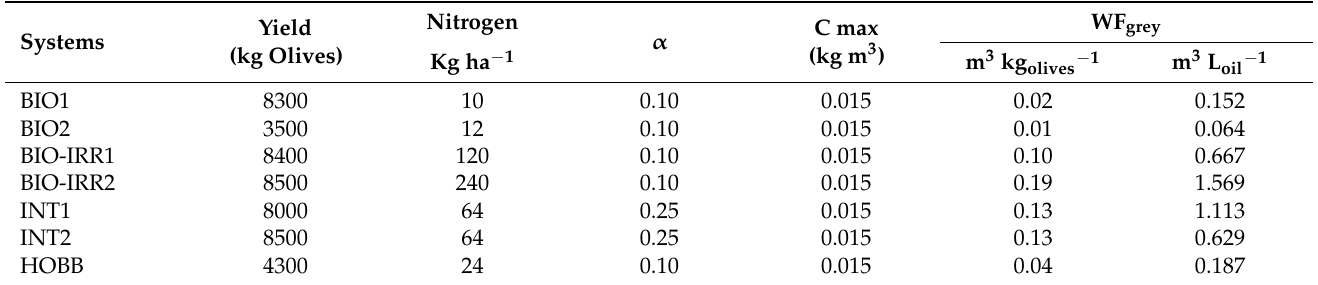
Table 7. Grey Water Footprint (WF grey ) of the analyzed systems ( α : the leaching run-off fraction; C max : the maximum acceptable concentration for the pollutant considered).